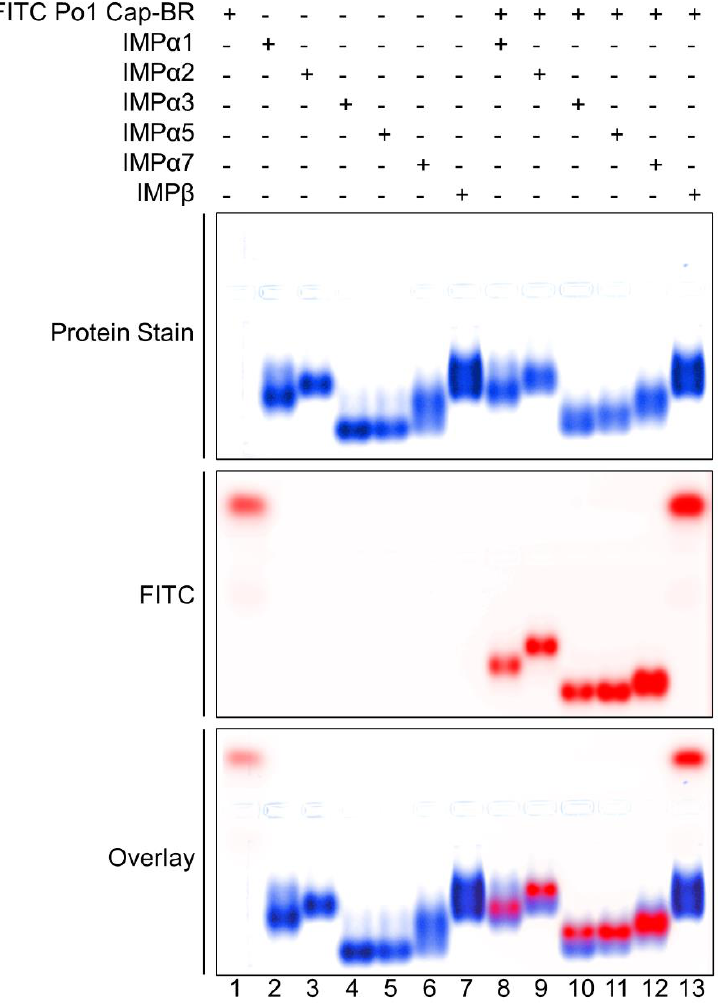
Figure 5. EMSA showing AAV Po1 Cap-BR with importin isoforms. EMSA showing AAV Po1 Cap-BR with ∆ IBB-IMP α isoforms spanning members from each of the three subfamilies (SF1: IMP α 1/2; SF2: IMP α 3; SF3: IMP α 5/7). The AAV Po1 Cap-BR peptide spans residues 119–158, and contains an FITC and Ahx linker (middle panel, shown in red). Proteins were stained using Coomassie blue stain (top panel; blue), and the overlay is represented in the bottom panel, where FITC peptide (red) overlays with protein (blue). EMSA results are representative of three independent experiments.